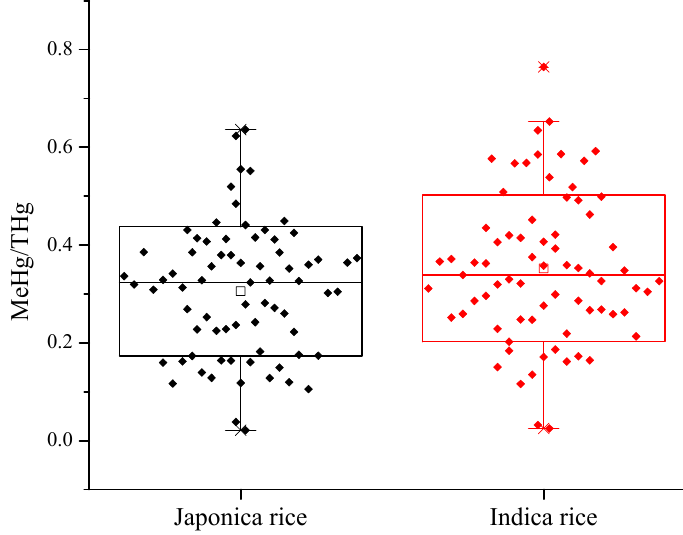
Figure 3. The proportion of the MeHg to THg in Japonica and Indica rice.